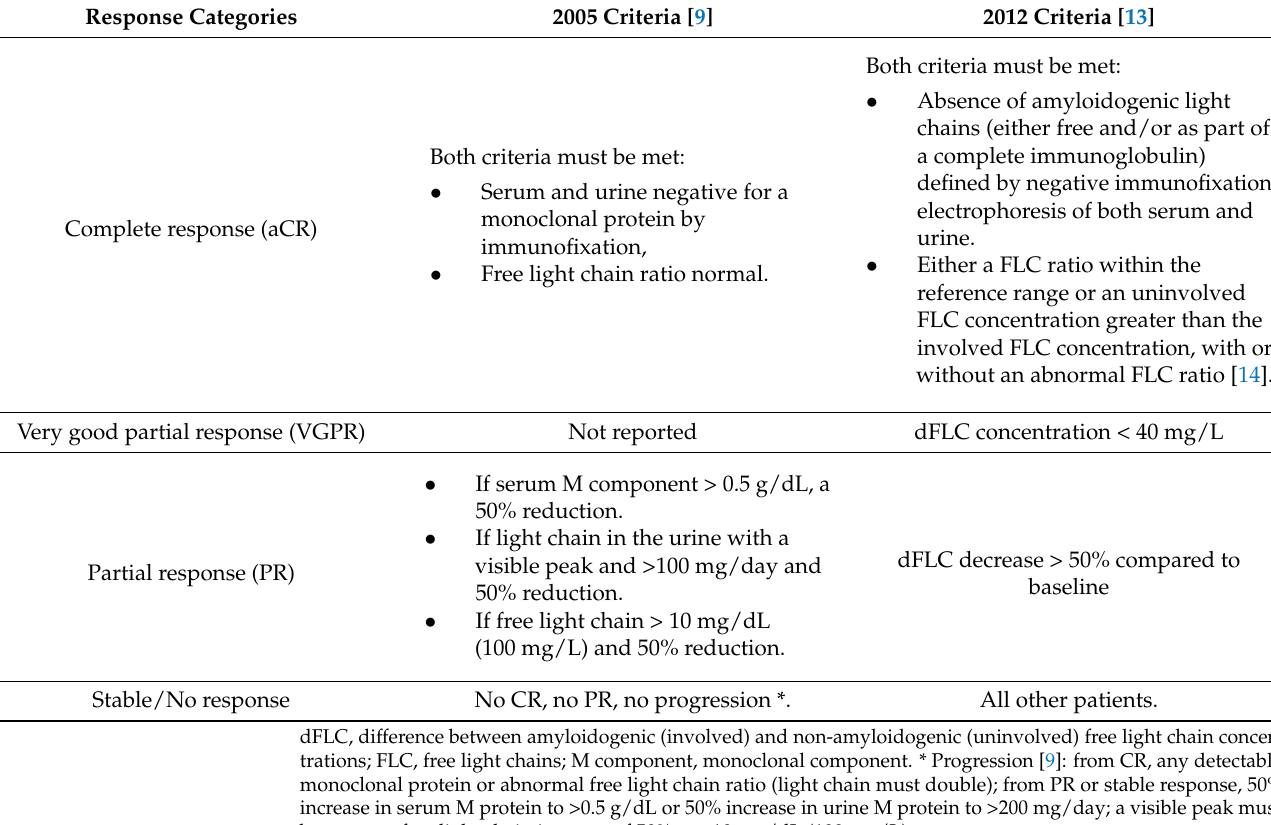
Table 1. Validated hematologic response criteria for AL